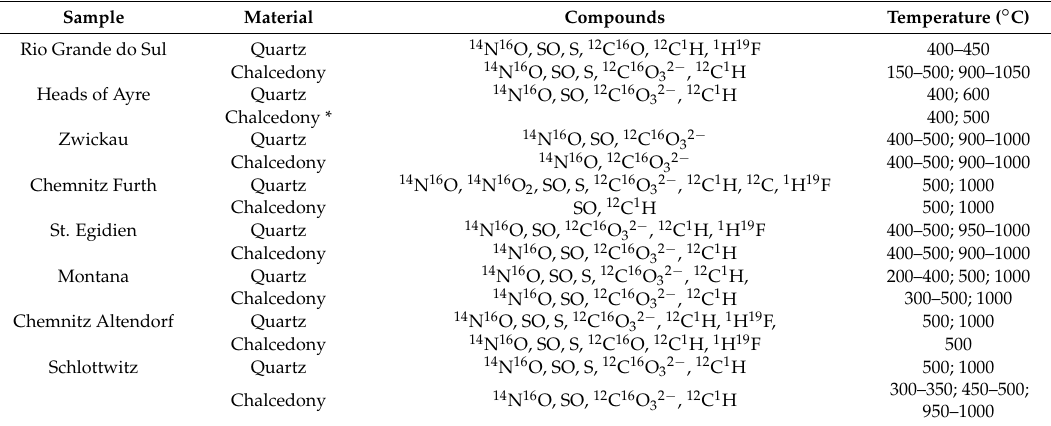
Table 2. Detected compounds and corresponding temperatures of degassing in the investigated agate